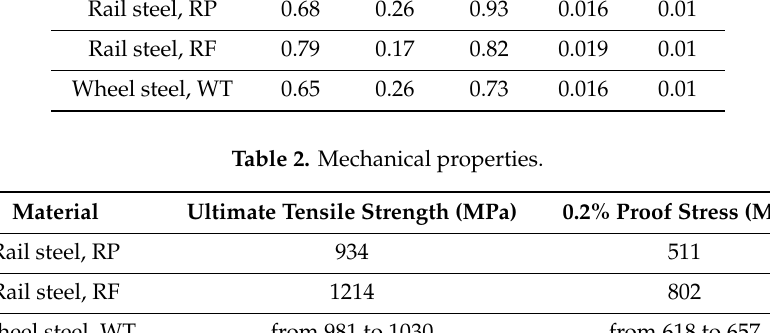
Table 1. Chemical composition (wt%).